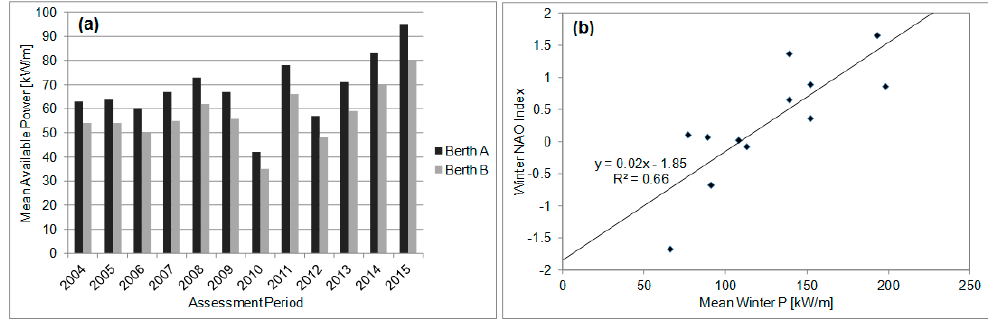
Figure 25. ( a ) Annual mean P at BA and BB and ( b ) regression analysis of winter North Atlantic Oscillation (NAO) index against winter mean wave power at BA.